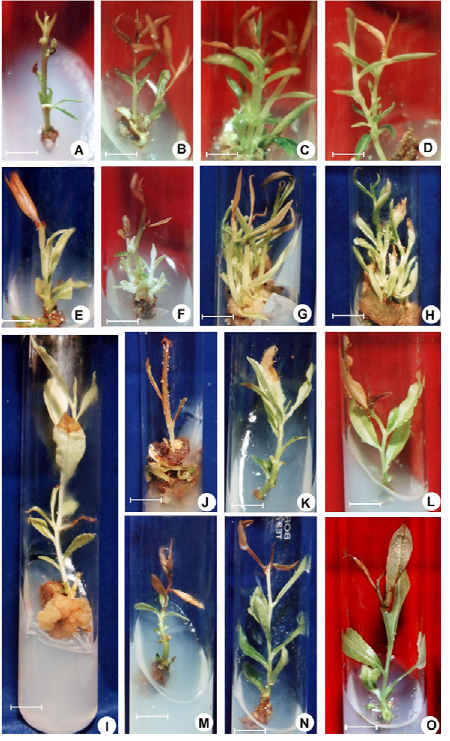
Fig. 2. Shoot tip necrosis in cultures of S. febrifuga . (A-F) Shoot necrosis in proliferating direct shoot cultures (Bar = 2.0, 2.6, 2.0, 2.1, 3.4, 3.3 mm) (G-J) Shoot tip necrosis in proliferating indirect shoot cultures (Bar = 3.3, 4.9, 6.0, 6.9 mm) (K-O) Shoot tip necrosis in cultures kept for rooting (Bar = 4.9, 5.2, 5.2, 6.2, 5.0